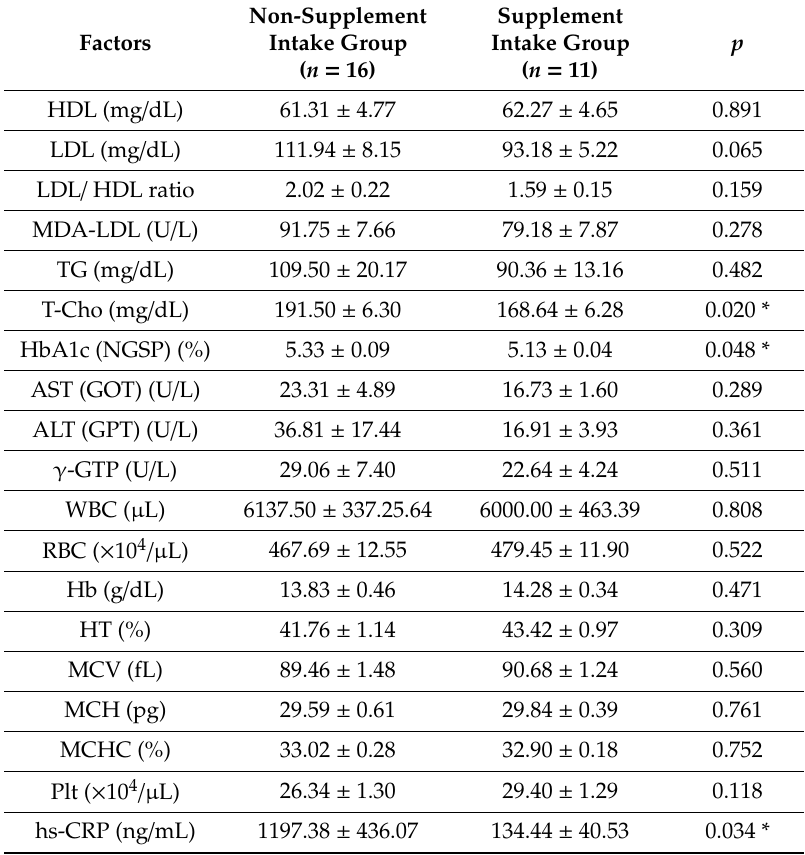
Table 4. Systemic data of the participants with or without antioxidative supplement